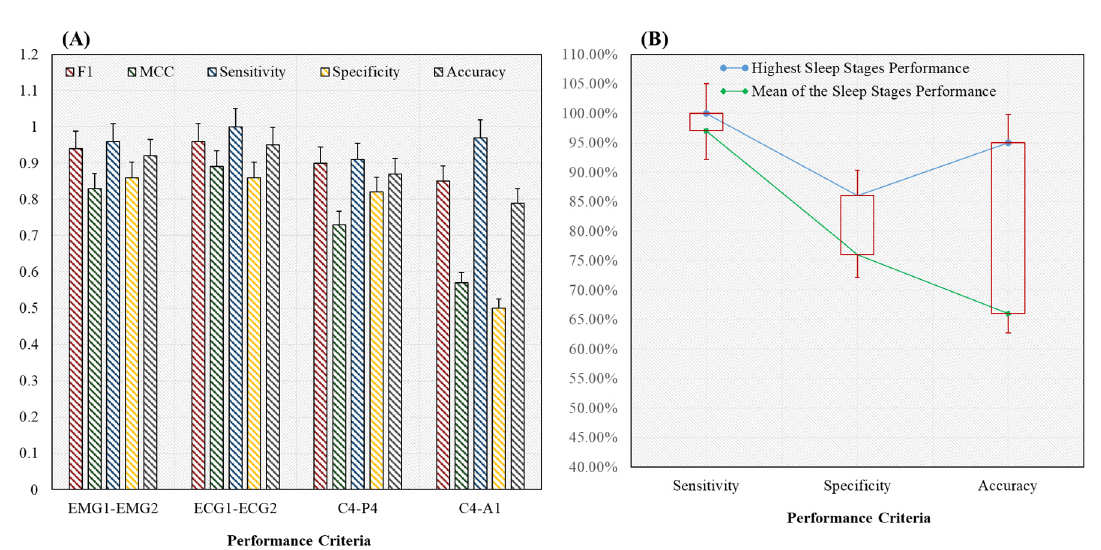
Figure 8. Performance analysis of the sleep stages (w and REM) classification using the novel 20-fold HML classifier. ( A ) Comparison between all channels such as EMG1-EMG2, ECG1, ECG2, C4-P4, and C4-A1 channels of the sleep stages classification. In addition, ( B ) highest and mean performance of the sleep stages classification. The ECG1-ECG2 channel of the ECG signal has the highest accuracy (95%) in the sleep stages classification.